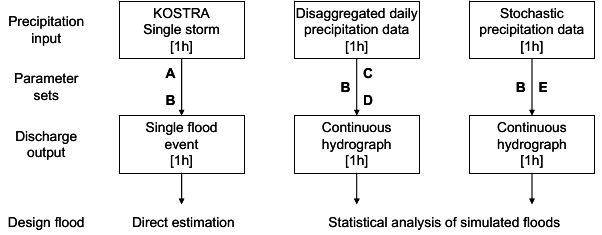
Fig. 5. Strategies for the estimation of design floods; the temporal Figure 5 . Strategies for the estimation of design floods; the temporal resolution of the data is given in brackets resolution of the data is given in